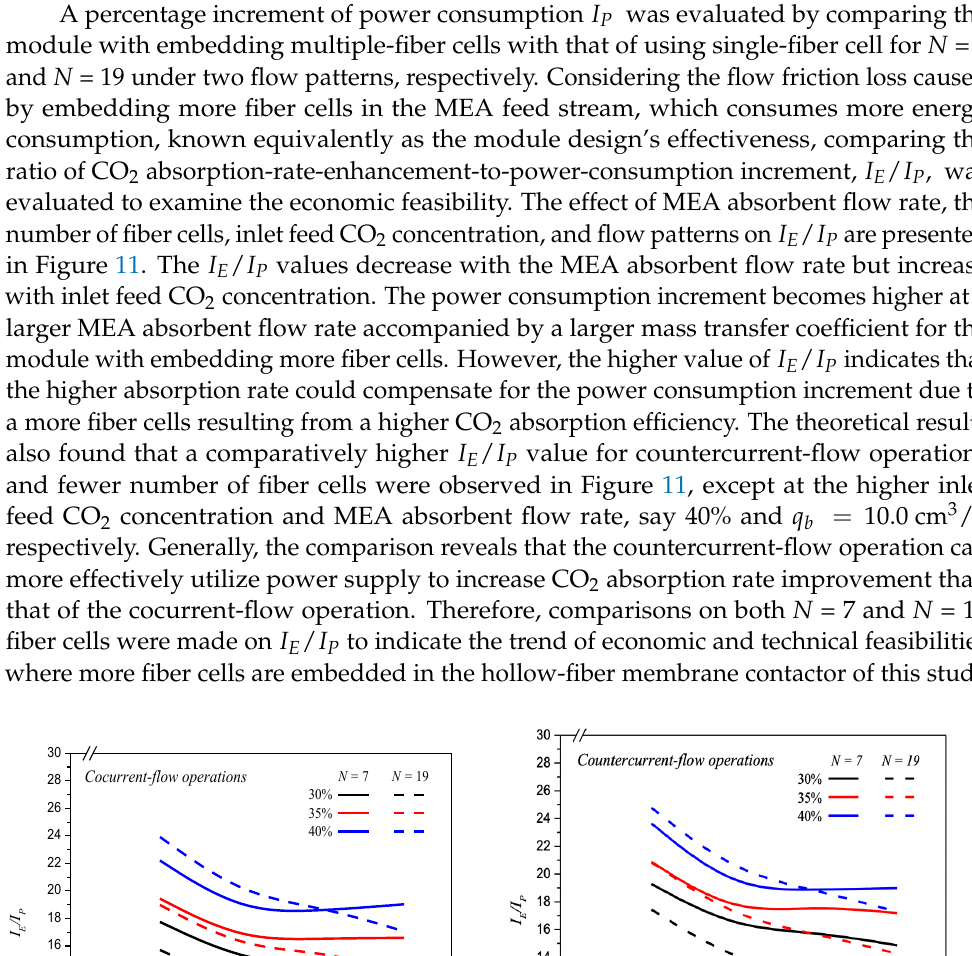
𝐼𝐼 𝐸𝐸 / 𝐼𝐼 𝑃𝑃 . 7. Conclusions